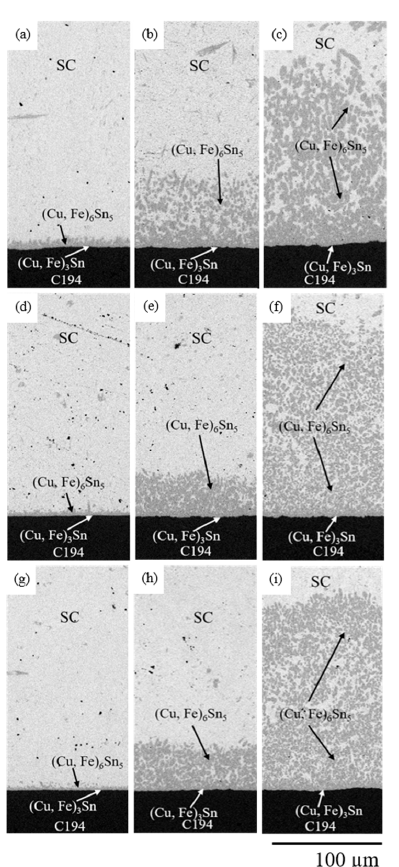
Figure 1. BEI micrographs of the SC/C194 reaction couples at 240 °C for ( a ) 0.5 h, ( b ) 4 h, and ( c ) 10 h; reacted at 255 °C for ( d ) 0.5 h, ( e ) 4 h, and ( f ) 10 h; and reacted at 270 °C for ( g ) 0.5 h, ( h ) 4 h, and ( i ) 10 h.